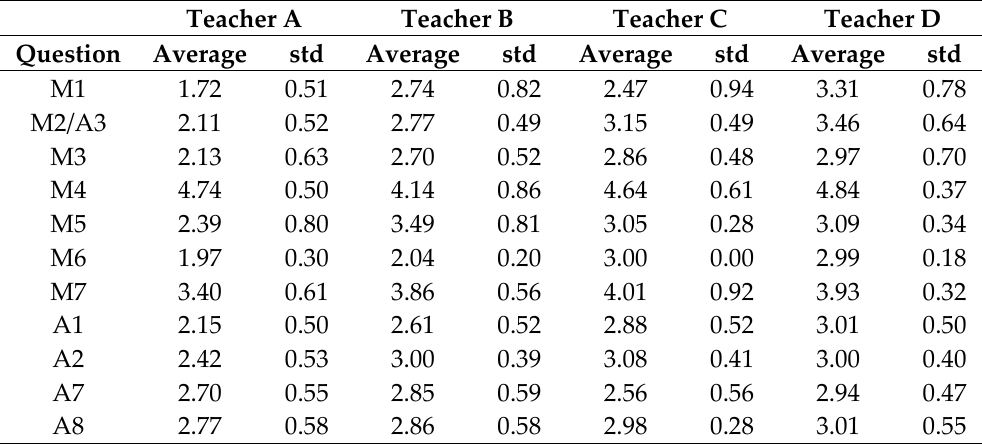
Table 4. Average and standard deviation of answer values on a scale of 1 to 5 during the whole pilot *.